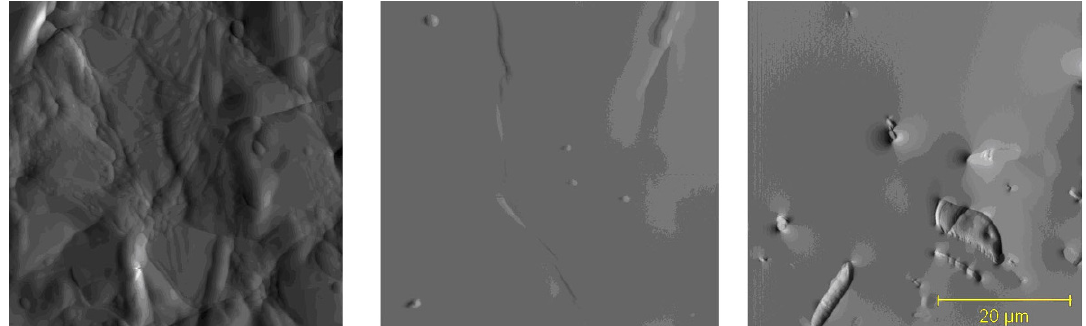
Figure 13. AFM images of glazes obtained using sol-gel-derived pigments: CoAl